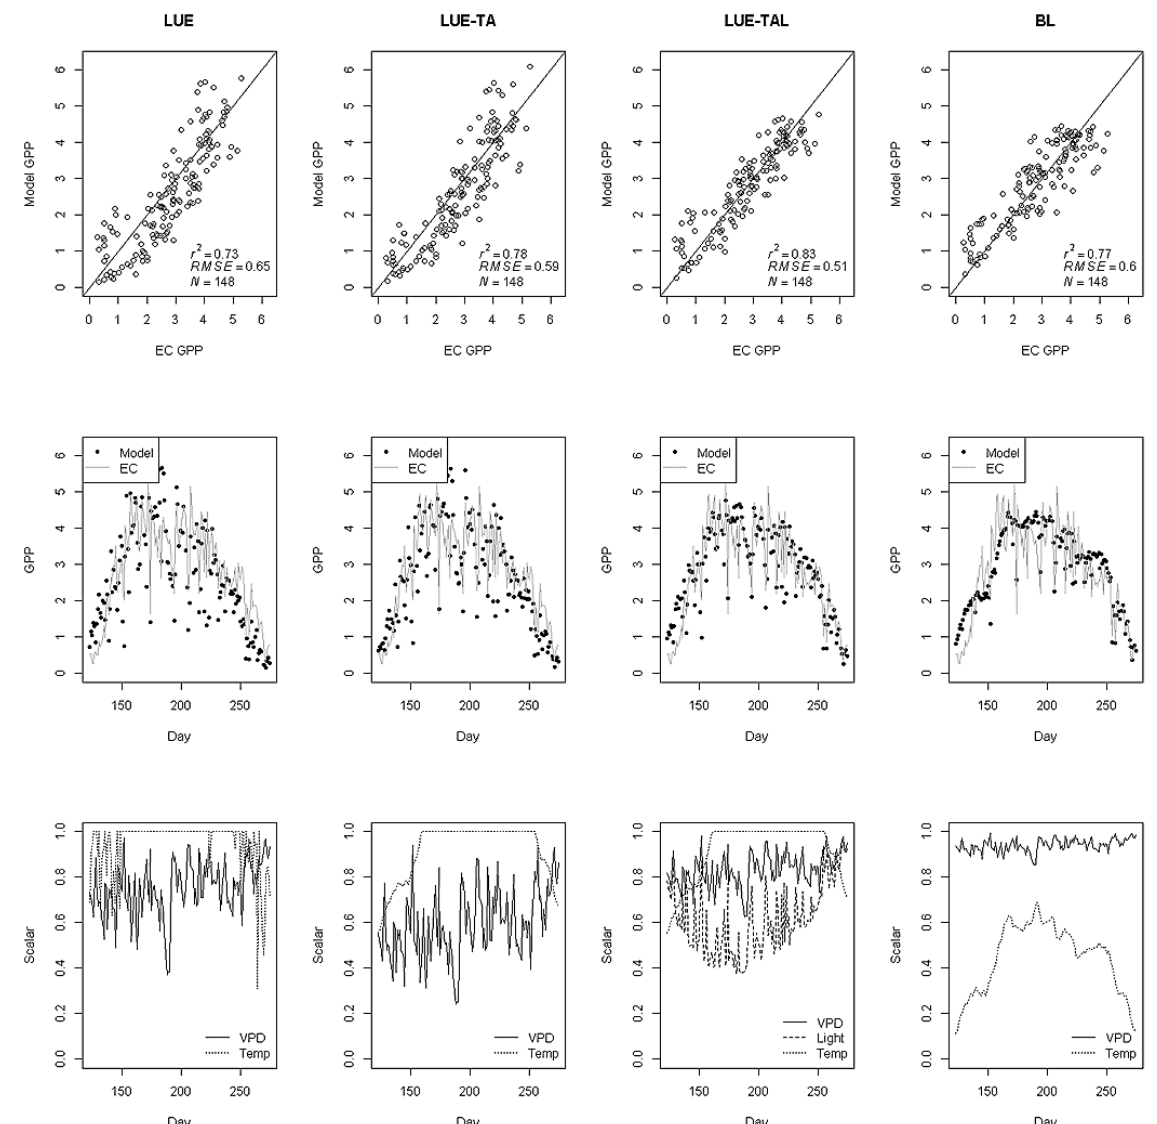
Fig. 4. Results for Hakasia, 2003, from the LUE (1st column), LUE-TA (2nd column), LUE-TAL (3rd column) and BL (4th column) models where the top row depicts scatter plots of EC GPP vs. model GPP, the middle row depicts the daily course of GPP (EC and model) and the bottom row depicts the environmental scalars for temperature and VPD. GPP in units of gCm − 2 d − 1 .